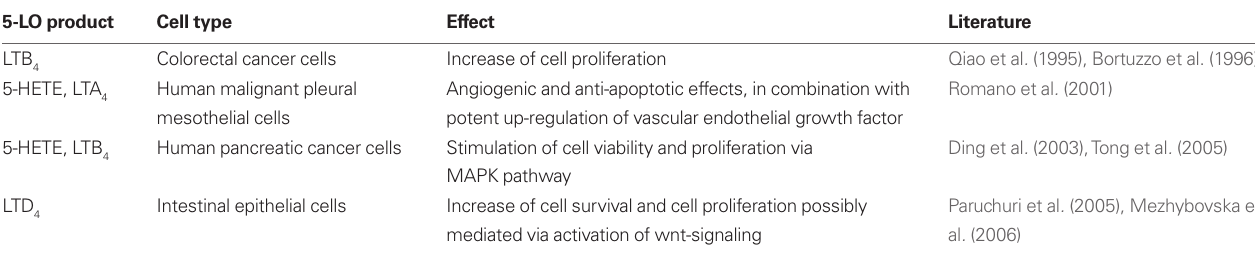
Table 2 | Mitogenic effects of 5-LO products in cell culture